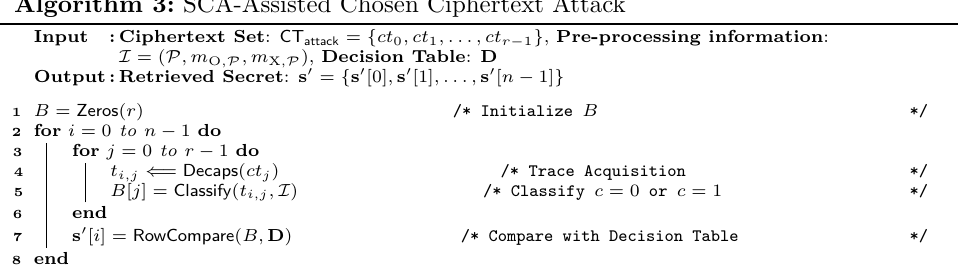
Algorithm 3: SCA-Assisted Chosen Ciphertext